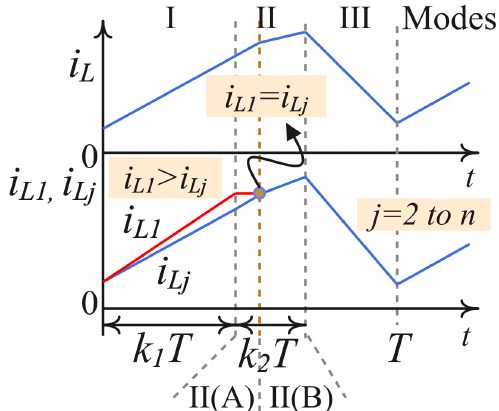
Figure 9. Current waveforms through inductors when L > L 1 and L = L 2 = L 3 ... L n